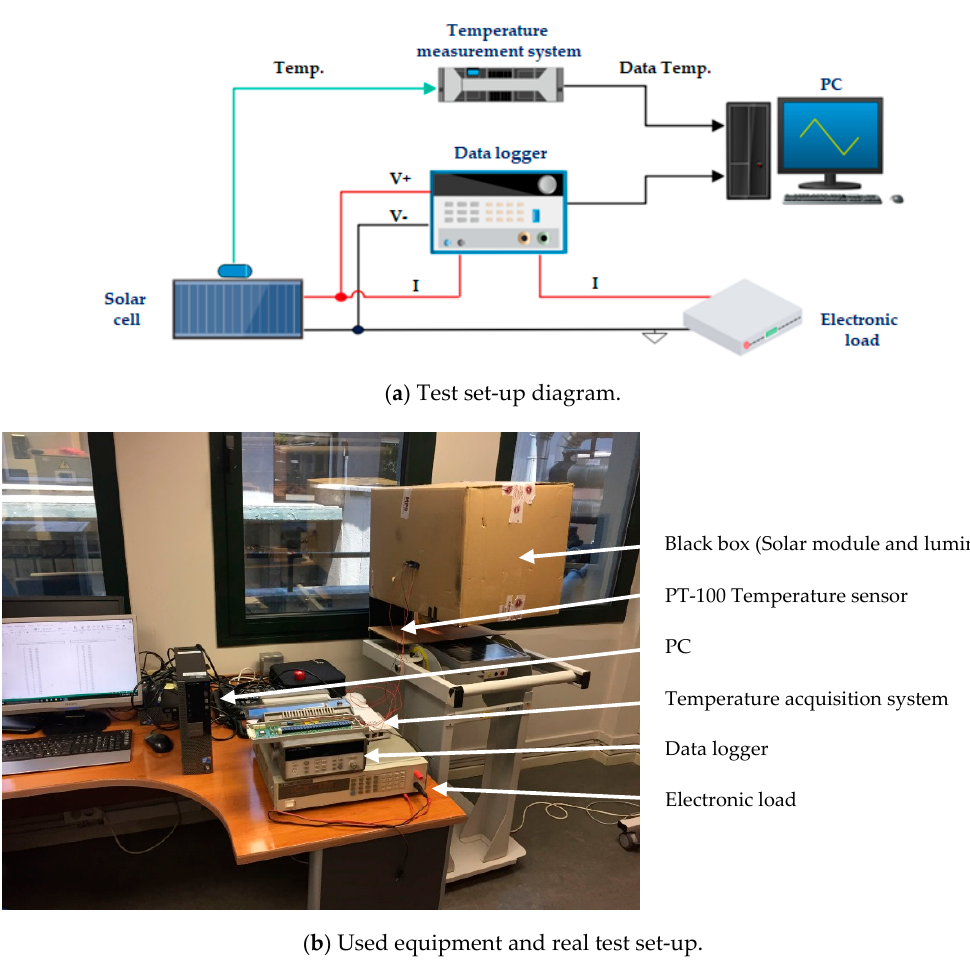
Figure 5. Photovoltaic cell test set-up.